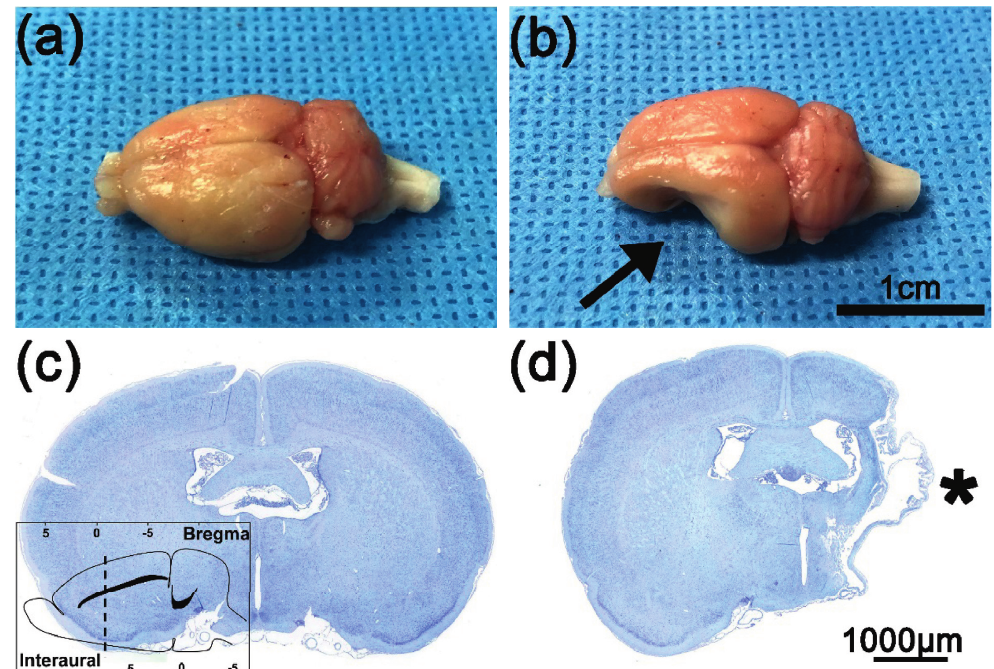
Figure 3: Cortical infarction in rats after the MCAO procedure. (a) Gross brain morphology in the control group. (b) Gross brain morphology in the MCAO and C7 neurotomy groups; the black arrow indicates the area of cortical infarction. Nissl staining in the (c) control group and (d) MCAO and C7 neurotomy groups; the black asterisk indicates the area of cortical infarction (bregma: − 0.84 to − 1.08mm; interaural: 8.16–7.92mm).